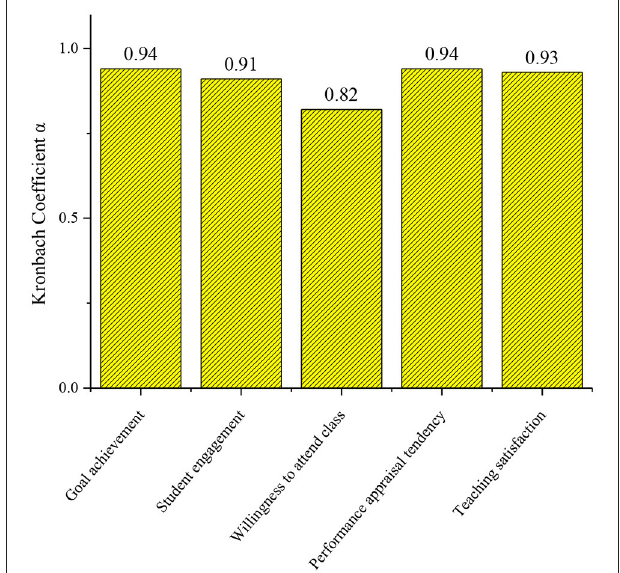
FIGURE 6 | Reliability of each dimension of the